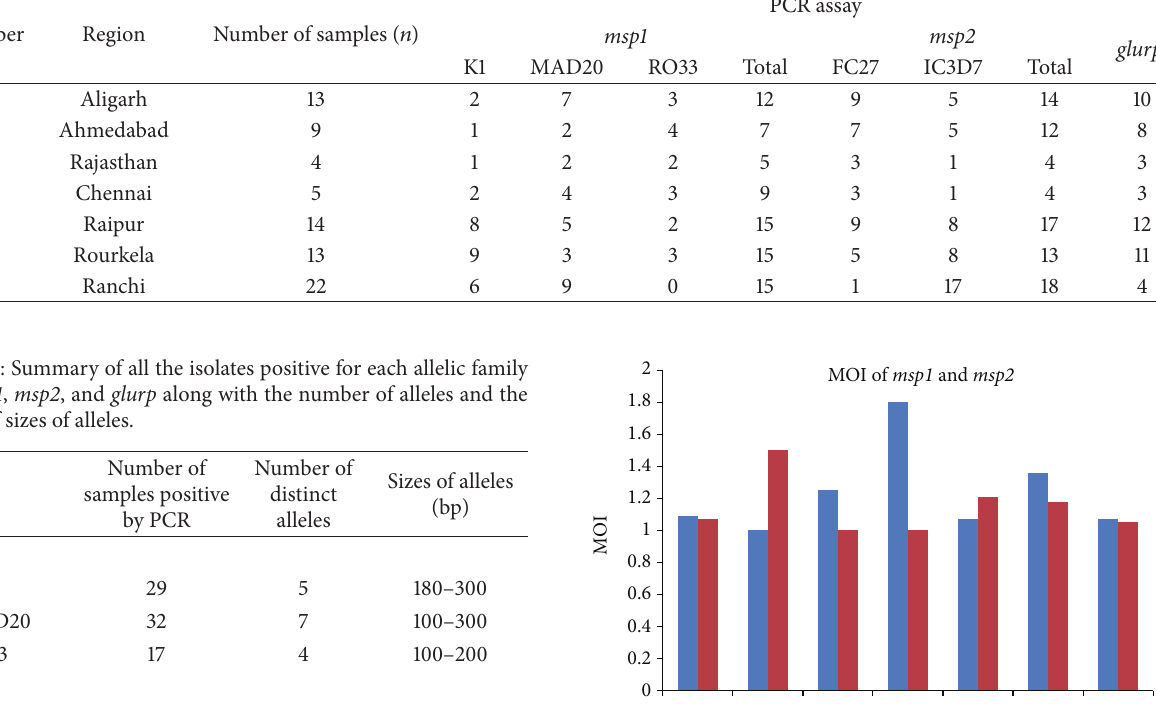
Table 2: Region-wise genetic diversity of P. falciparum by msp1 , msp2 , and glurp . S. number